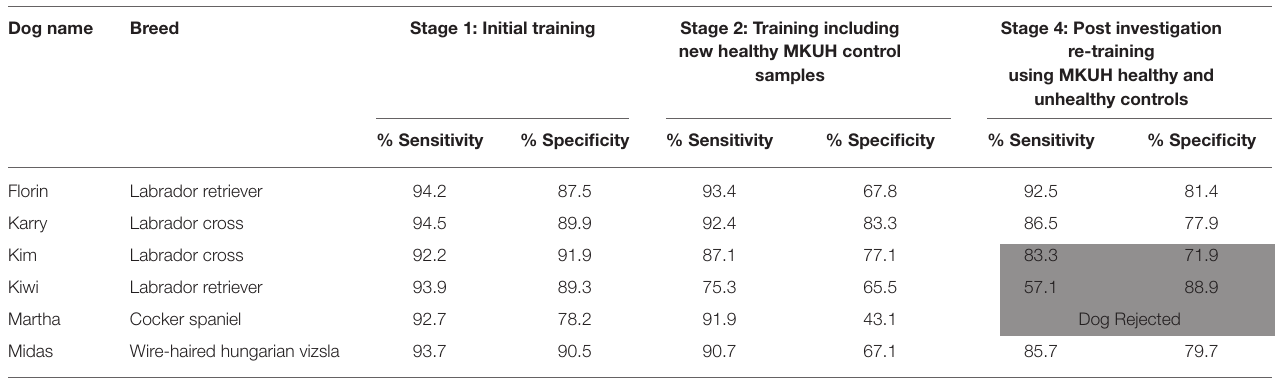
TABLE 1 | Demographics and training performance of each of the six female